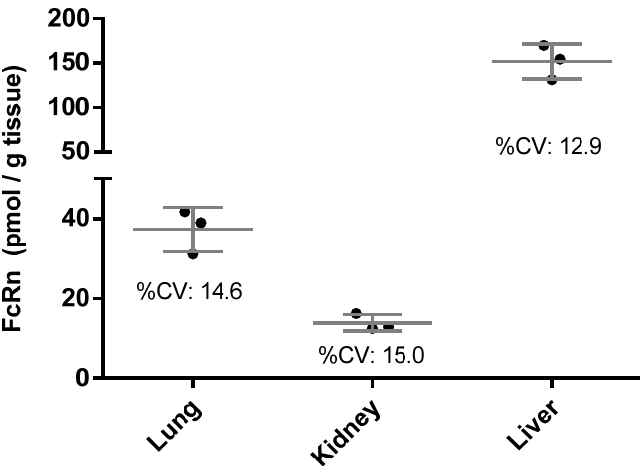
Figure 2. Reproducibility of FcRn measurement in normal human liver, lung and kidney tissues from independently prepared lysates from dissected tissue portions of the same tissue sample. Table 1. Summary statistics of human FcRn tissue assay qualification.